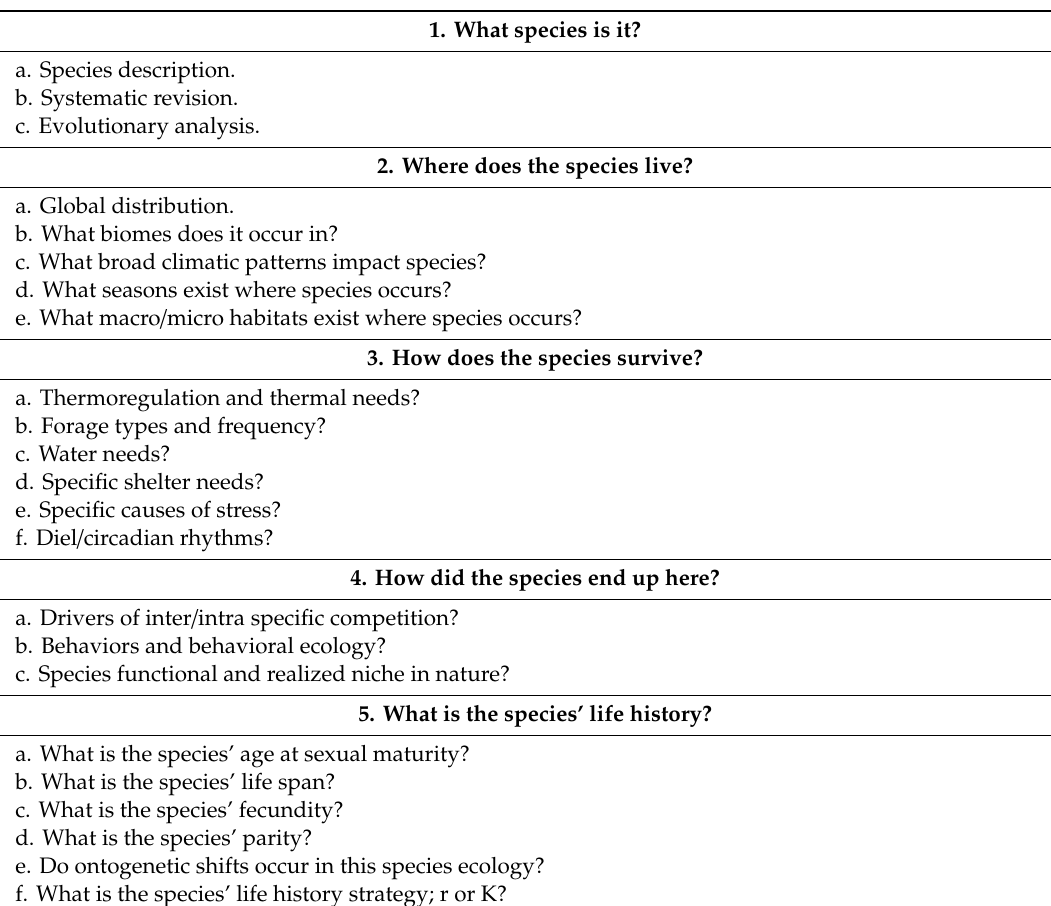
Table 1. Bartholomew’s proposed natural history questions and their proposed relationship to herpetoculture. Bolded questions are Bartholomew’s broad questions (numbers) with sub-questions (letters) that fall under